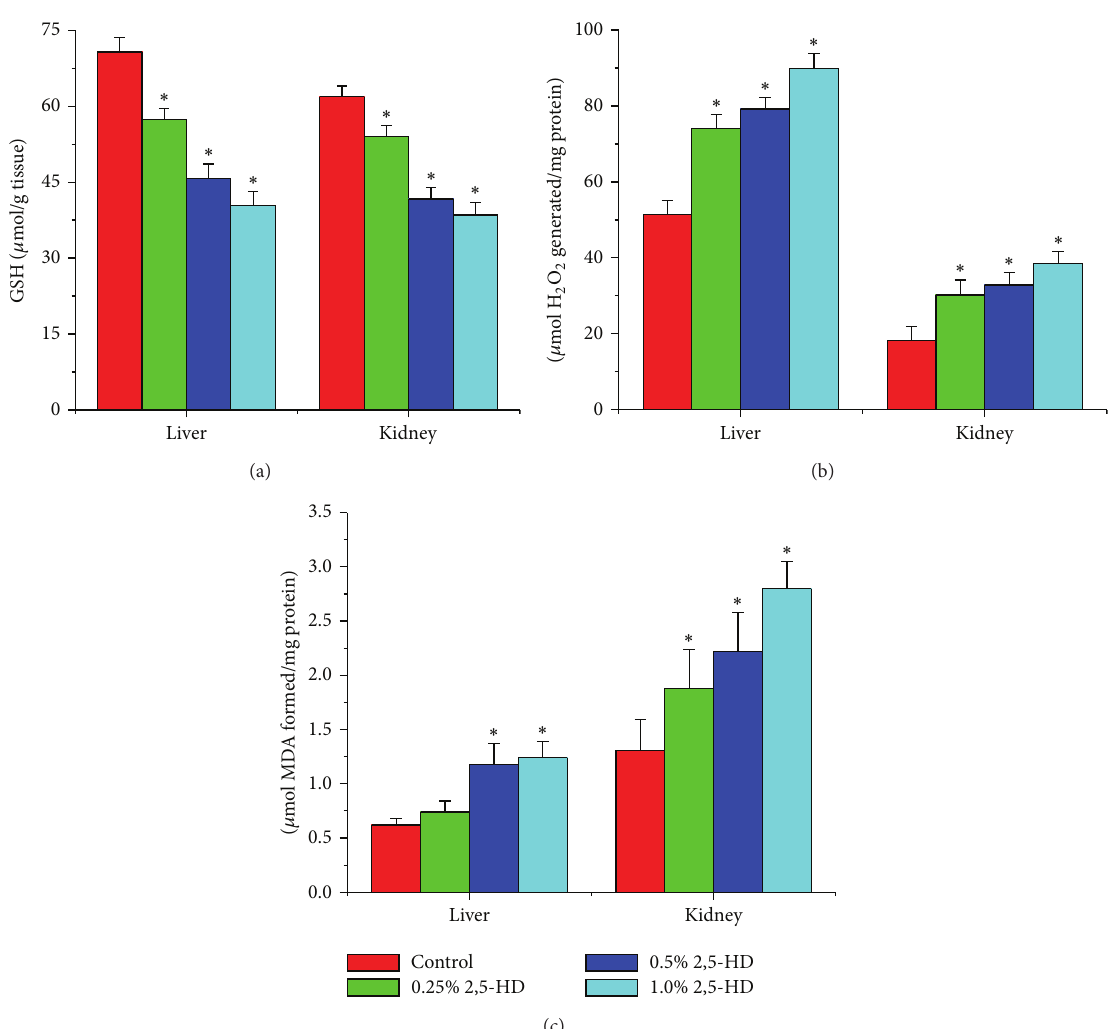
Figure 3: Comparison of hepatic and renal GSH, H 2 O 2 generation, and MDA levels among the control and treated rats. Data are described as mean ± SD of eight animals per group. Asterisk indicates statistical difference from control ( 𝑃 < 0.05